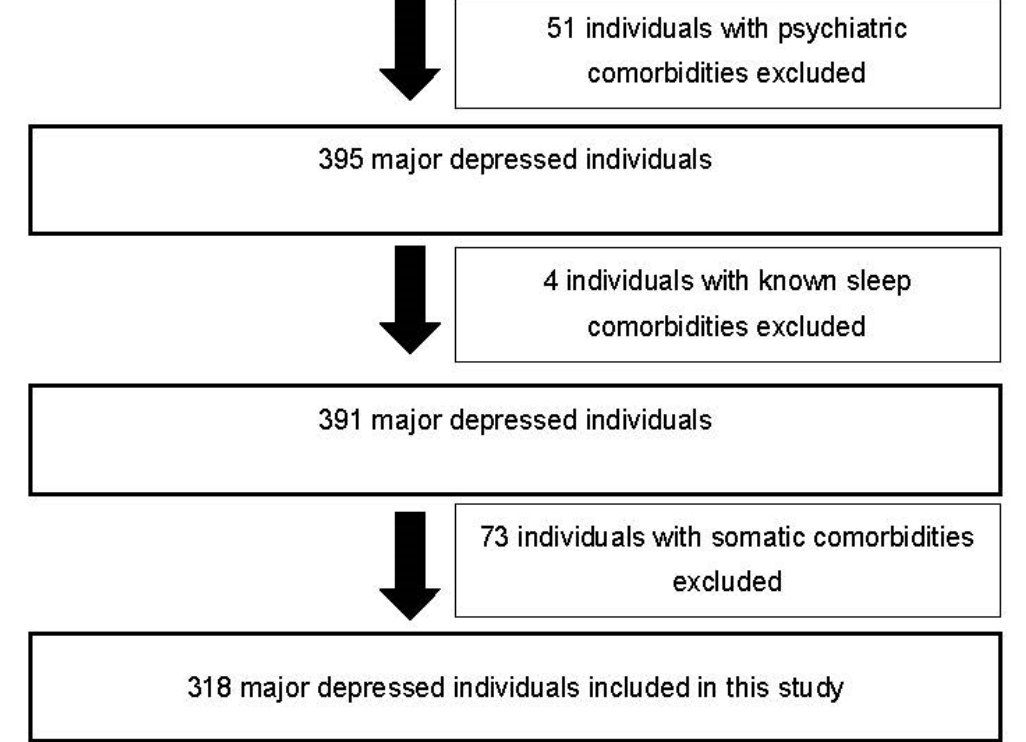
Figure 1. Selection diagram of major depressed individuals included in this study.